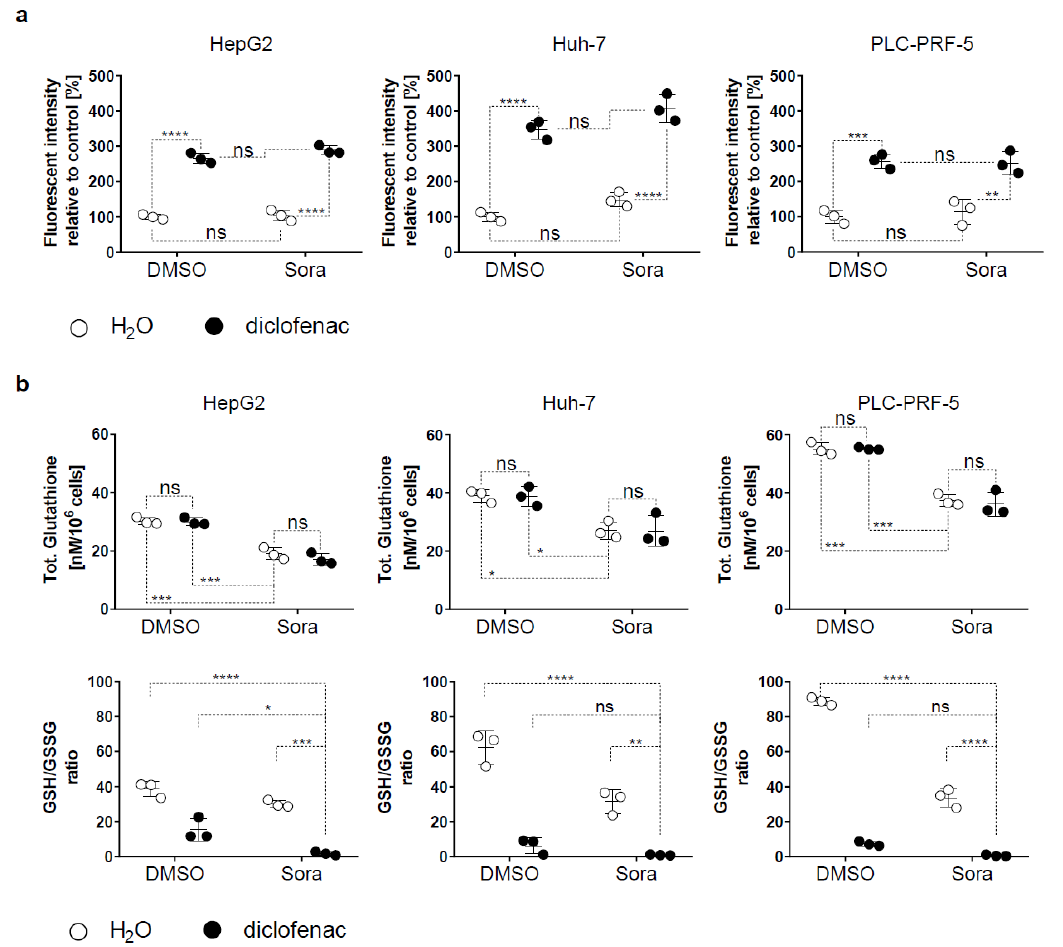
Figure 2. Diclofenac / sorafenib co-therapy increases oxidative stress in HCC cell lines. ( a ) HCC cells were treated with sorafenib (Sora, 5 µ M) or diclofenac (100 µ M), or DMSO or H 2 O as controls, for 5 h. ROS levels were determined and expressed as mean fluorescent intensity relative to control (DMSO / H 2 O treated cells). Each point represents the mean intensity of one independent experiment run in duplicates. ( b ) HCC cells were treated with sorafenib (Sora, 5 µ M) or diclofenac (100 µ M), or DMSO or H 2 O as controls, for 5 h. The total glutathione (upper panels) and the ratio of reduced glutathione to oxidized glutathione (GSH / GSSG ratio, lower panels) were quantified. Each dot represents the mean of an independent experiment run in duplicates. p value: * < 0.05, ** < 0.01, *** < 0.001, **** < 0.0001, ns: nonsignificant as indicated by a two-way ANOVA with Sidak’s multiple comparisons test.